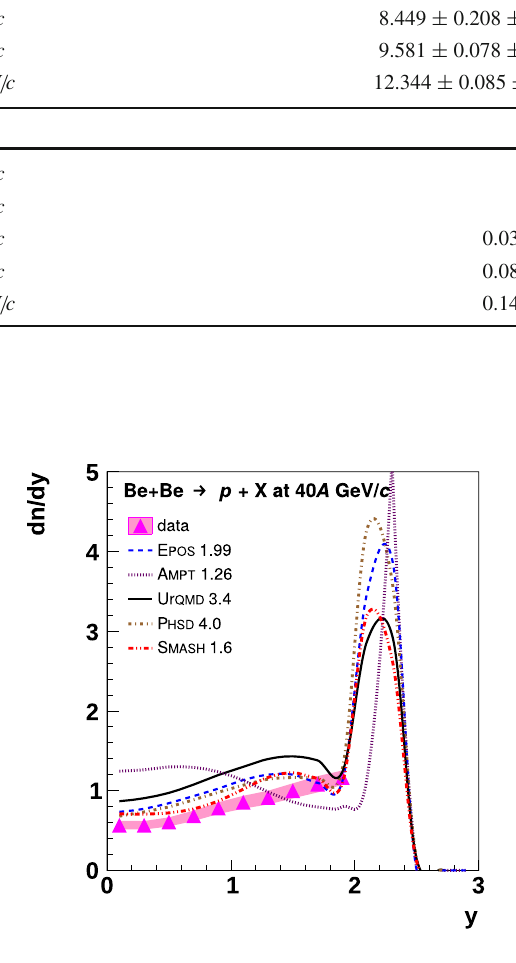
Fig. 31 Proton rapidity distribution in the 20% most central Be+Be collisions at 40 A and 150 A GeV / c compared with predictions of the Epos 1.99 [16,31] (blue dashed line), U r qmd 3.4 [33,34] (black